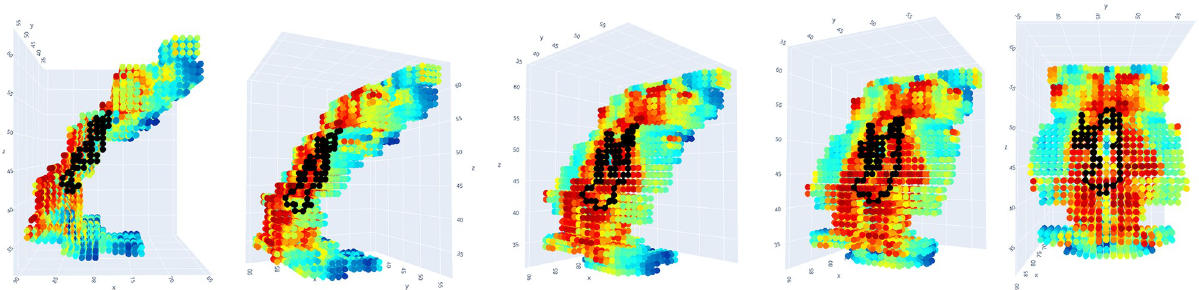
Fig 10. A loop representing the task-correlated persistent vine in the ACC mask for time index 1 is superimposed on a heat map of the fMRI signal amplitude at the same time index. The loop passes through voxels of high signal amplitude and is non-contractible, i.e., cannot be continuously contracted down to a point without passing through voxels of significantly lower amplitude.